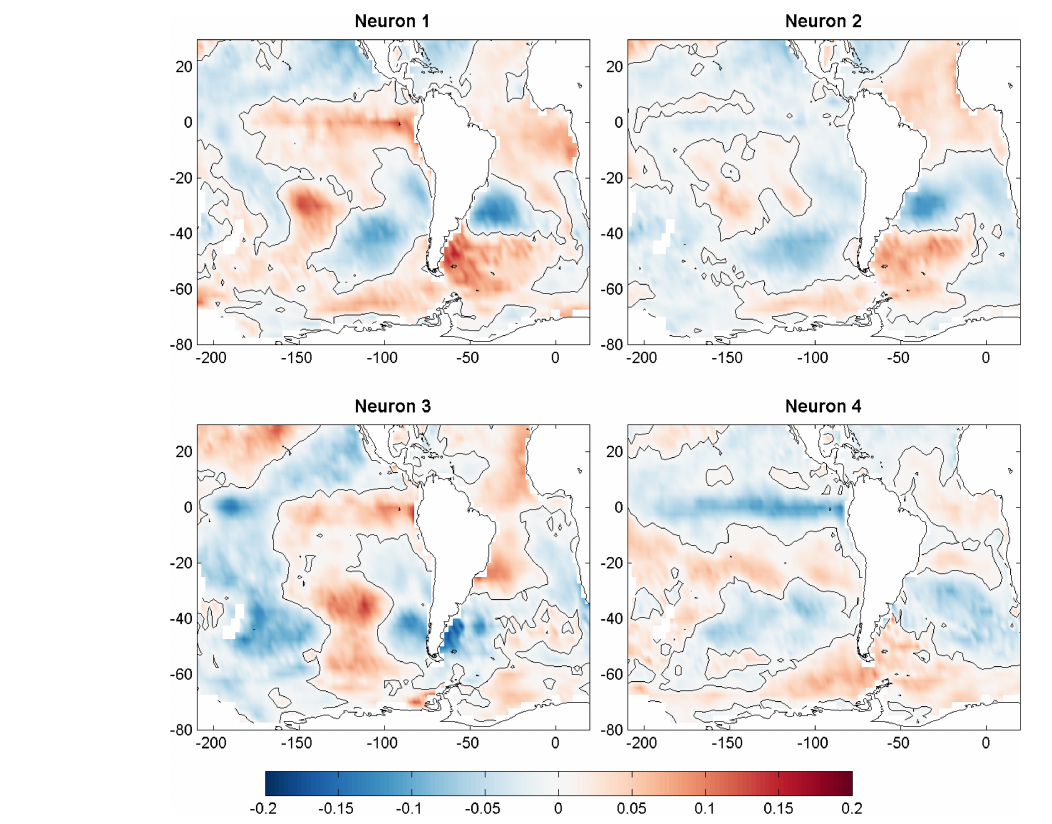
Figure 8. Showing 15-day filtered sea surface temperature (SST) anomalies ( ◦ C) averaged over each neuron class. The zero contour line is also